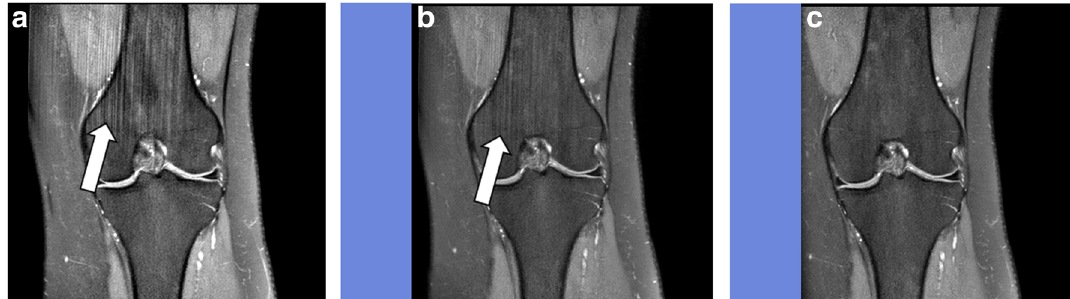
Fig. 5 Streaky-linear artefact type C. Coronal reconstructed 3D PD sequence of the knee with large FOV and without rest slab ( a ). The streaky-linear artefacts are depicted on the coronal reconstructed image ( white arrow ). If a rest slab ( blue band ) is placed with a small gap near to